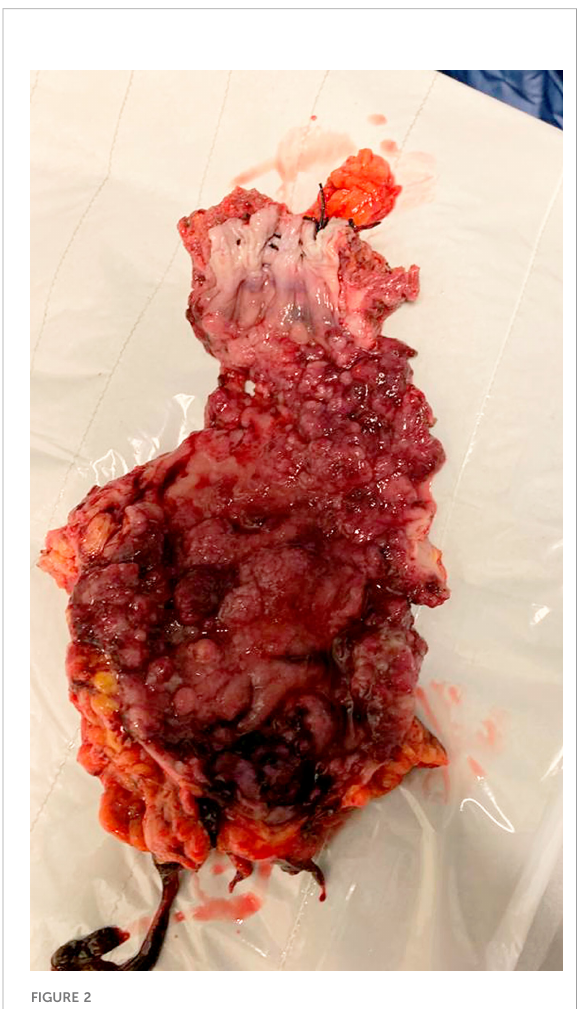
FIGURE 2 Gross specimen showing multiple foci of adenocarcinoma on background of tubulovillous adenoma with dysplasia in